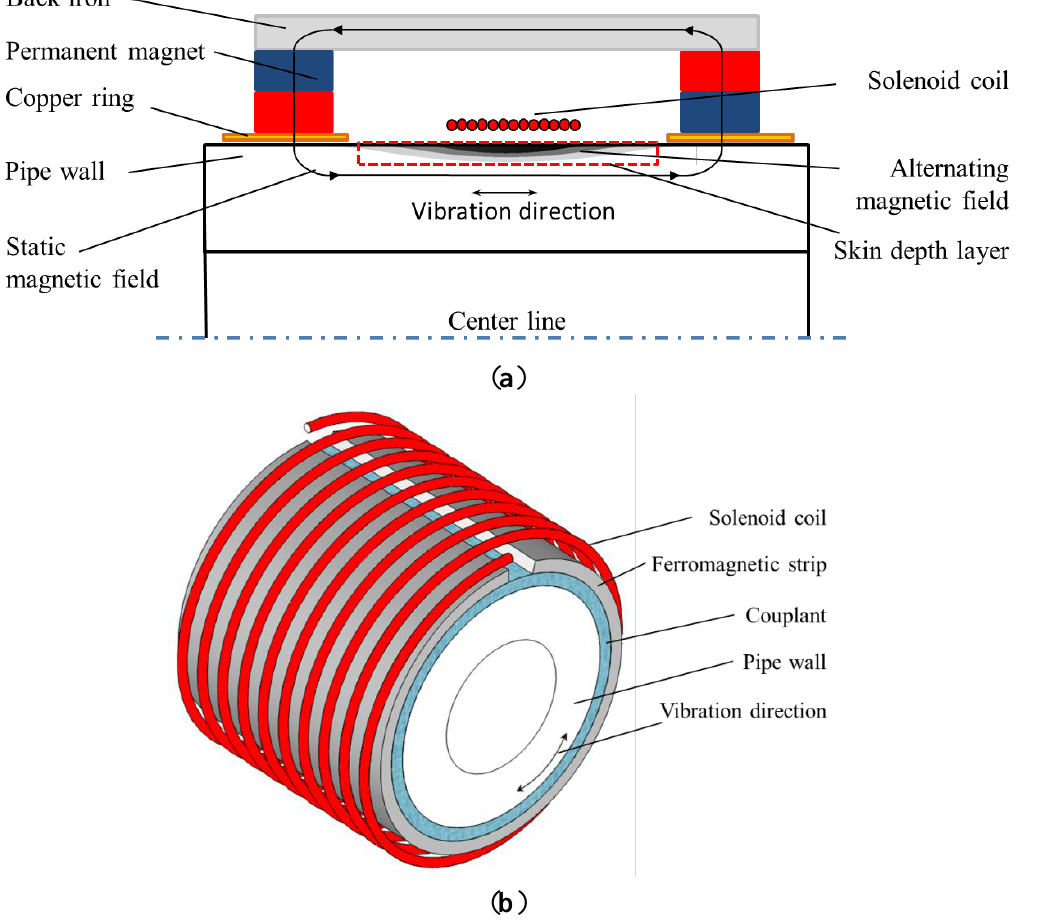
Figure 10. The guided wave generation progress ( a ) using the non-contact transmitter, ( b ) using the contact